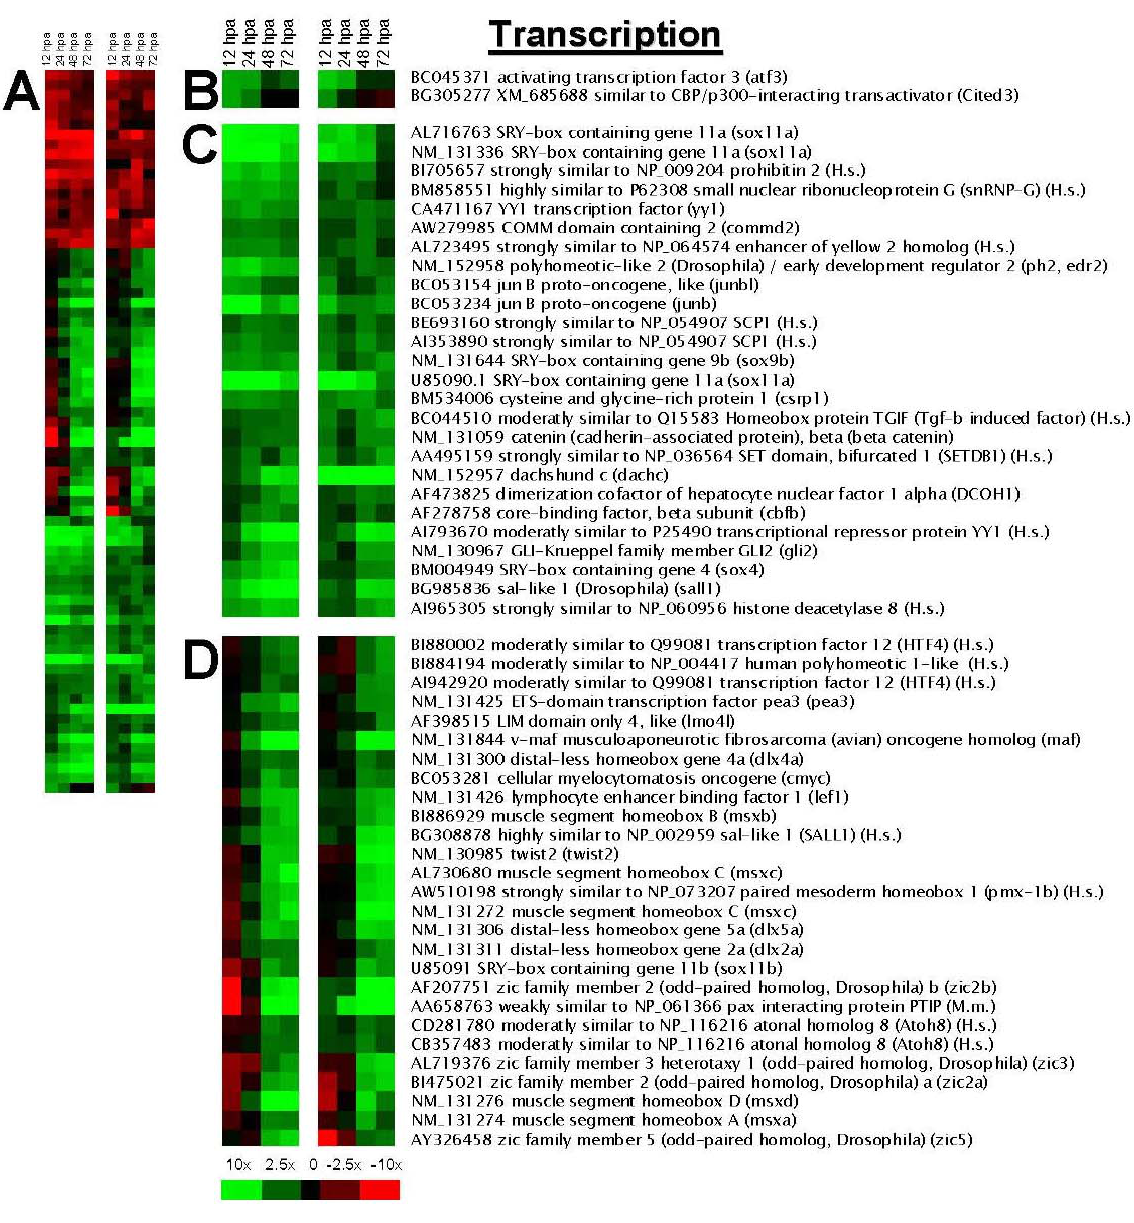
FIGURE 5 . Expression patterns of genes involved in transcription. (A) Hierarchical clustering of all transcription factors or genes involved in transcription. (B–D) Expression patterns, GenBank accession numbers, and names of transcription genes, which showed increased expression early (12 and 24 hpa, B), late (48 and 72 hpa, D), or throughout regeneration (C). H.s., Homo sapiens; M.m., Mus